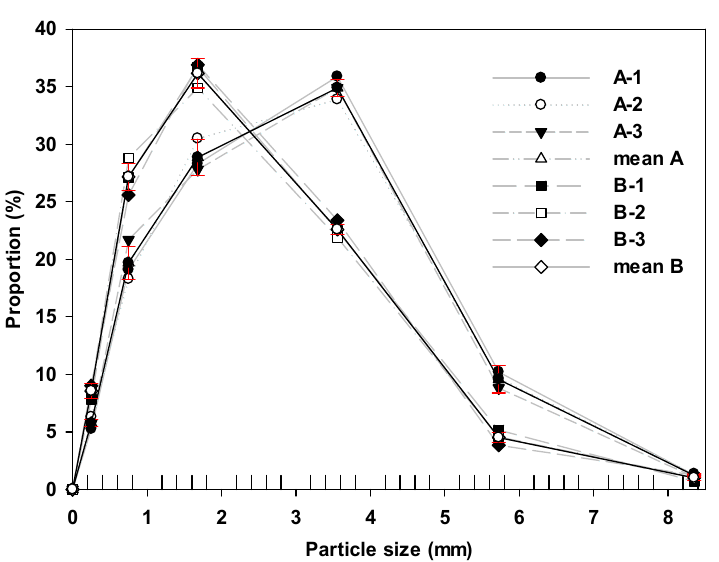
Figure 1. Proportion of perlite particle size measured at six particle grades for A and B. A: Turkey; B: China